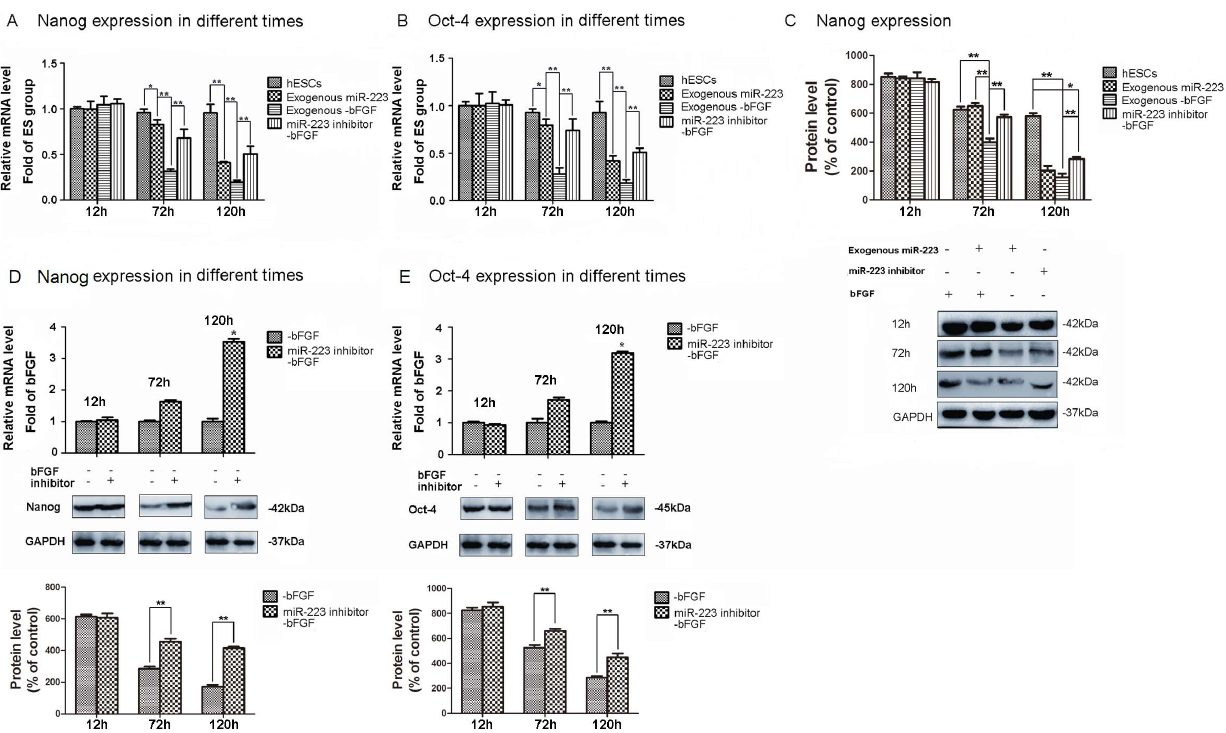
Figure 2. MiR-223 induces the differentiation of hESCs. Using qRT-PCR, Nanog ( A ) and Oct-4 ( B ) mRNA levels were assayed in control cells, cells expressing exogenous miR-223 with and without bFGF withdrawal, and cells expressing a miR-223 inhibitor that underwent withdrawal of bFGF for 12, 72, and 120 h (* p , 0.05, ** p , 0.01; n=6). ( C ) Levels of Nanog were detected by western blot 12, 72, and 120 h after withdrawal of bFGF for the groups. Levels of mRNA and protein were also assayed for Oct-4 ( D ) and Nanog ( E ) in the presence or absence of an miR-223 inhibitor 12, 72, and 120 h after withdrawal of bFGF (* p , 0.05, ** p , 0.01; n=6). For western blots, detection of GAPDH was used as a loading control and protein bands were semi-quantified using imaging analysis software. Data are expressed as the mean 6 SD and are representative of the three independent experiments that were performed. *p , 0.05, **p , 0.01, n=3.